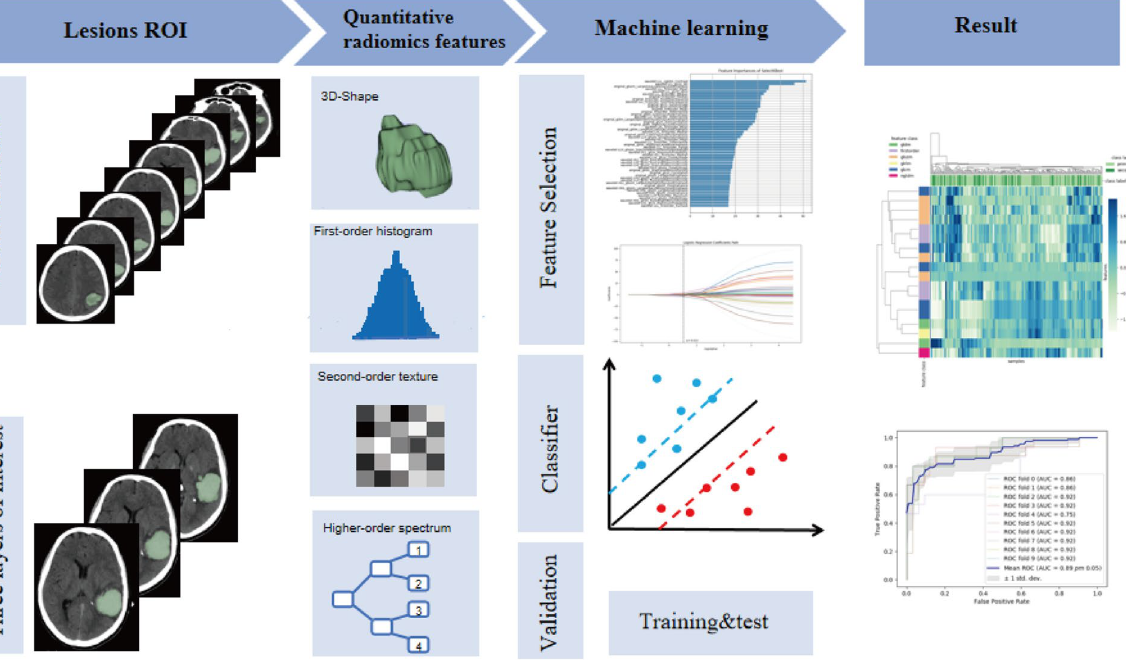
Figure 2. Workflow of image